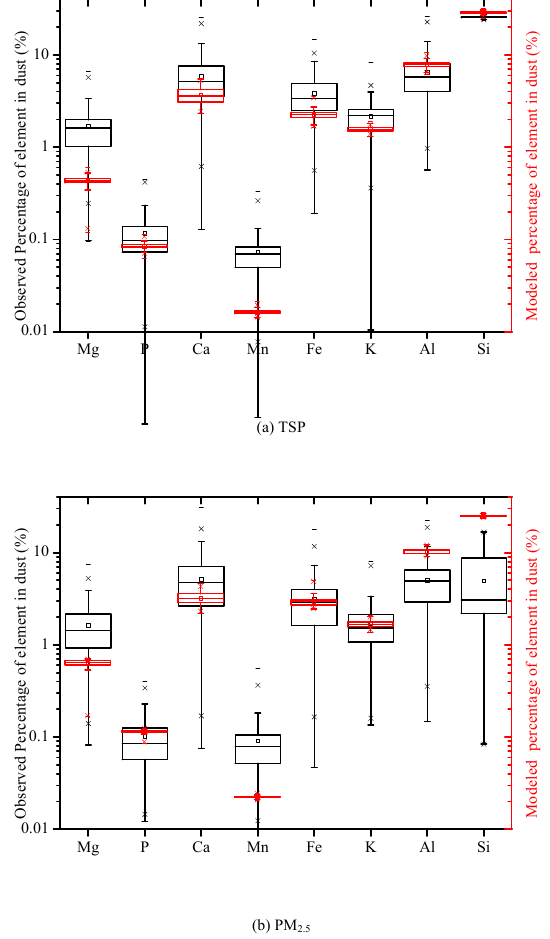
Figure 11. Mean and quartile modeled and observational fractions of elements in (a) TSP and (b) PM 2 . 5 for all sites together, the box line presents 25, 50 and 75%, individually. Here we calculate the elemental fractions and average the fractions temporally for each site and compare to